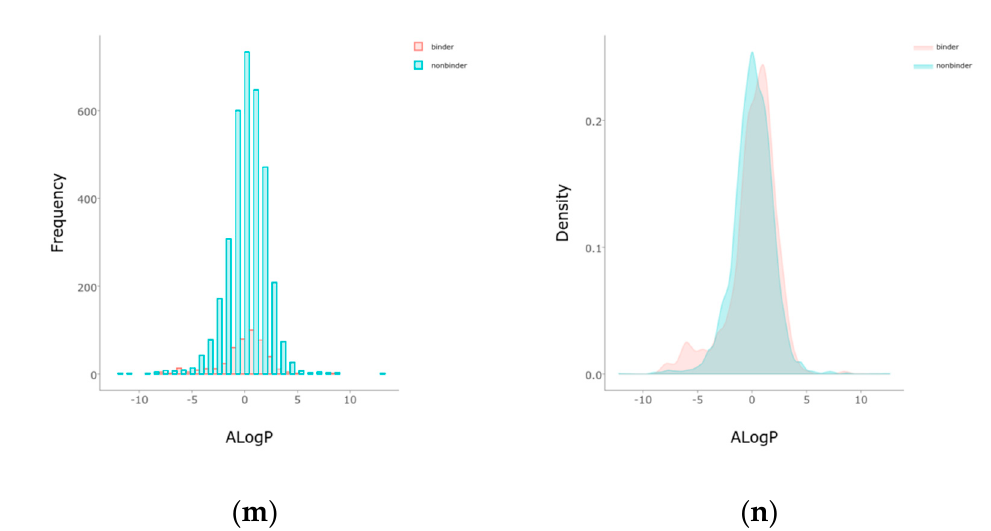
Figure 7. PUMA: ( a ) principal component analysis; ( b ) balance; and histograms and density plots for binders and nonbinders in the evaluation dataset according to: ( c , d ) MW (g/mol); ( e , f ) TPSA (Å 2 ); ( g , h ) number of rotational bonds (nRotB); ( i , j ) number of hydrogen bond donors (nHBDon); ( k , l ) number of hydrogen bond acceptors (nHBAcc); and ( m , n ) Alog P .